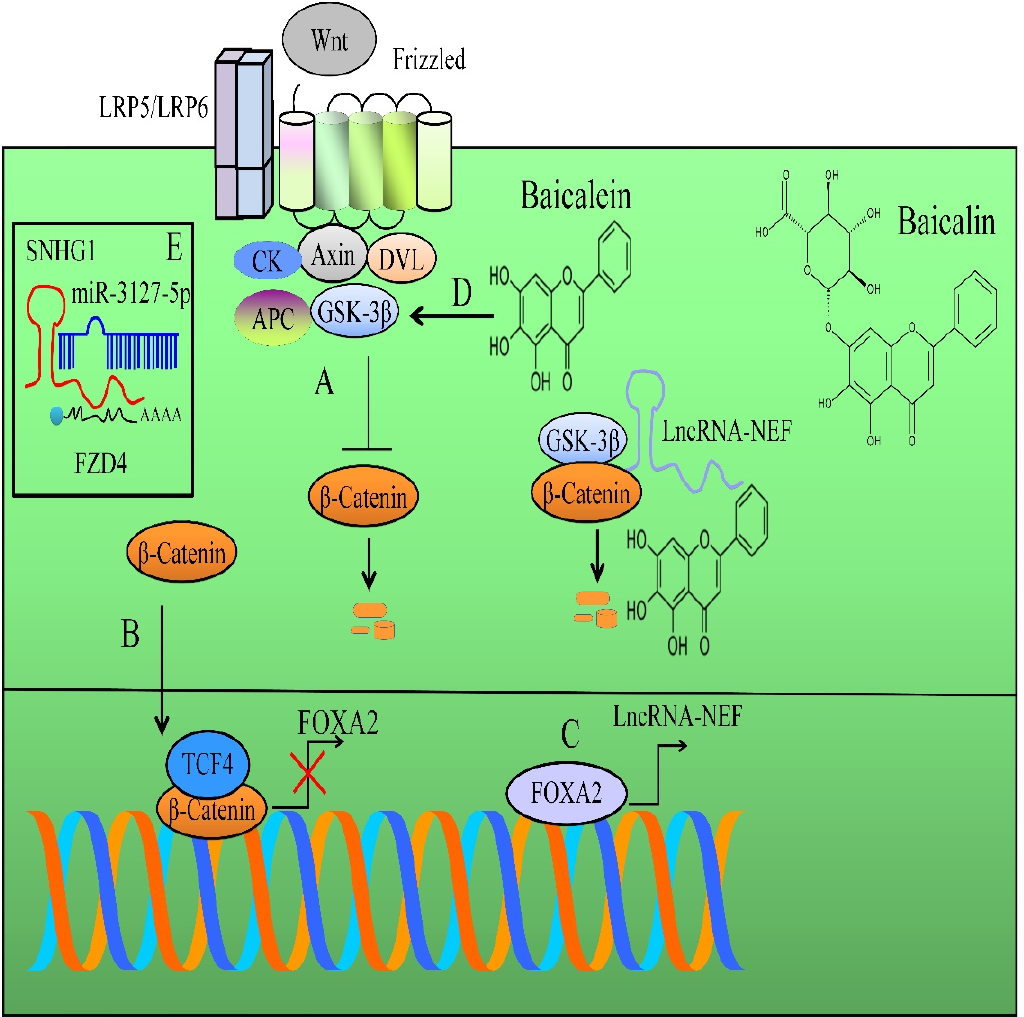
Figure 1. (A) Diagrammatic representation of WNT/ β -catenin pathway. APC and axin recruited β -catenin, and after sequential phosphorylations of specified amino acid residues in amino-terminal region, β -catenin is poly-ubiquitinated by β -TrCP and tagged for degradation by the proteasomal machinery. (B,C) β -catenin transcriptionally repressed FOXA2. FOXA2 stimulated the expression of lncRNA-NEF. LncRNA-NEF interacted physically with β -catenin and increased the binding of GSK3 β with β -catenin and facilitated phosphorylation and degradation of β -catenin by proteasomal machinery. (D) Baicalein also promoted GSK-3 β -mediated phosphorylation of β -catenin and subsequent degradation. (E) SNHG1 antagonized miR-3127-5p-mediated targeting of FZD4. SNHG1 antagonized miR-3127-5p-mediated targeting of FZD4 (Figure 1). Ectopic expression of SNHG1 remarkably increased Wnt/ β -catenin signaling but inhibition of SNHG1 remarkably blocked Wnt/ β -catenin target gene networks. Ectopic expression of SNHG1 antagonized baicalein-mediated inhibitory effects on Wnt/ β -catenin signaling. Baicalein significantly impaired the growth of subcutaneous xenografts in mice inoculated with SNHG1-overexpressing HeLa cells [48]. GSK-3 β -mediated phosphorylation makes β -catenin a recognizable target for ubiqui- tylation and consequent proteasomal degradation, thus inhibiting nuclear accumulation of β -catenin (Figure 1). Baicalein stimulated miR-25 expression and reduced β -catenin levels. Furthermore, GSK-3 β level was reported to be enhanced in baicalein-treated cancer cells